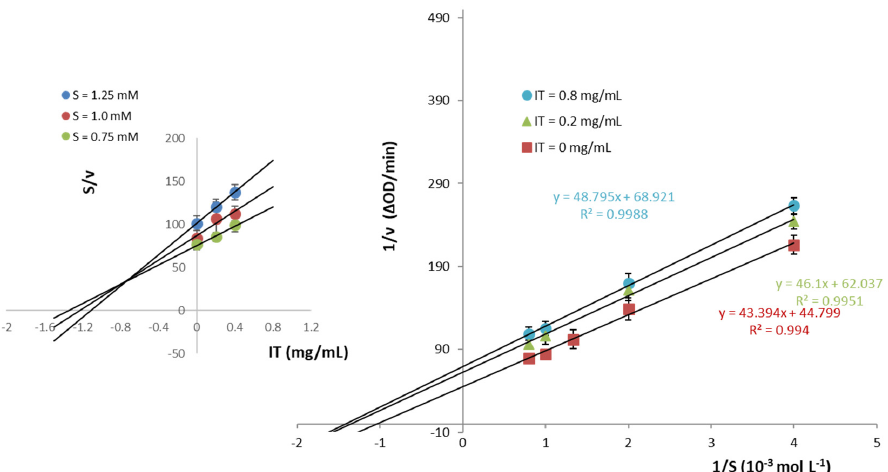
Figure 2. Lineweaver-Burk (L-B) of α -Amylase in the presence of inulin from topinambur (IT). The inset depicts the Cornish-Dowden plot to determine the K’ i constant.